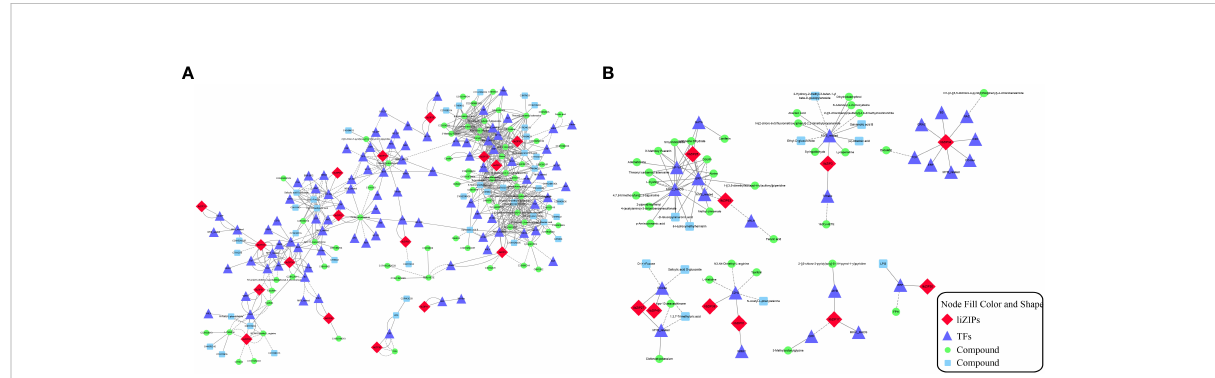
FIGURE 9 Metabolite association diagram of IibZIP genes and other transcription factors. (A) Association diagram of all differentially expressed bZIP genes, transcription factors and metabolites. (B) Association diagram of metabolites with the strongest associations with 10 bZIP genes. Different shapes and colors represent different substances. Solid lines indicate positive correlations and dashed lines indicate negative correlations.